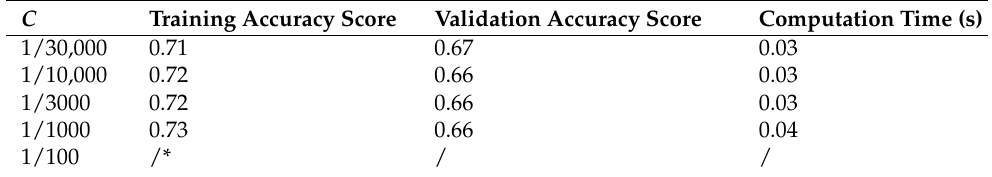
Table 4. Prediction performances of SVM with different values of C on the training and validation sets. C